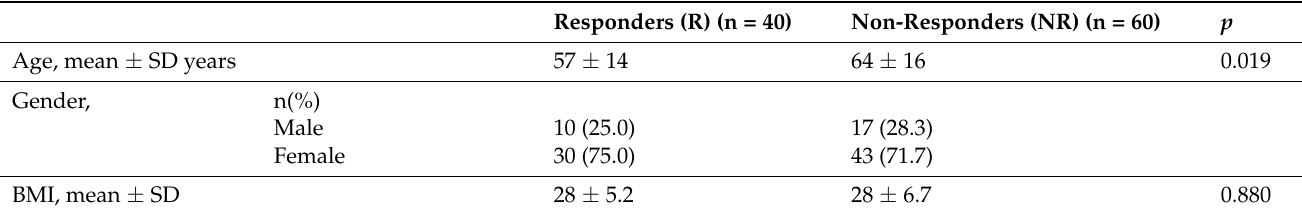
Table 1. Patient demographic characteristics across responder